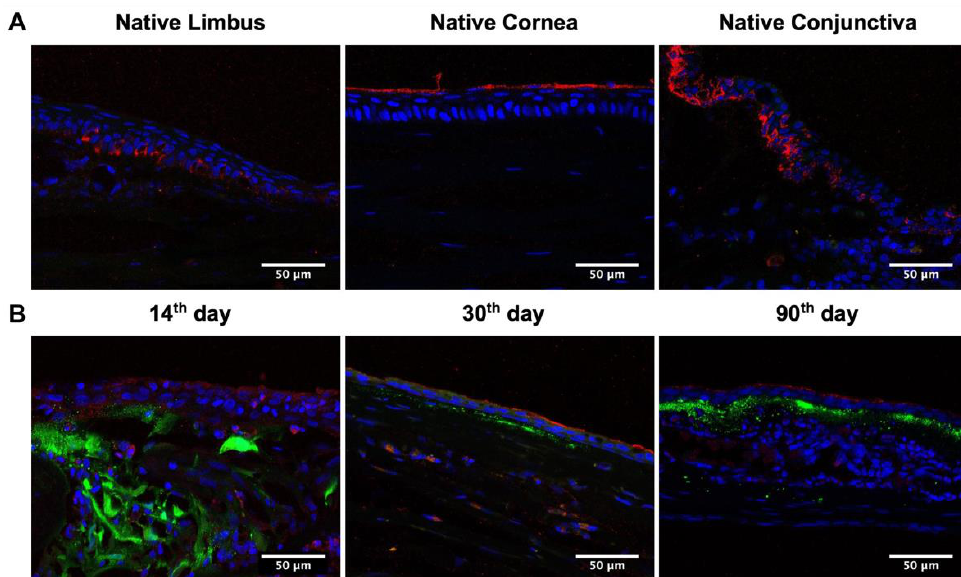
Figure 5. Immunohistochemical staining of rabbit corneas at different time points after transplanta- tion of L-MSCs-EGFP. Red—staining with antibodies against cytokeratin 15; green—GFP channel; blue—DAPI. ( A ) Native tissue in the area of the limbus, cornea, and conjunctiva. ( B ) Corneal tissue on the 14th, 30th, and 90th days after transplantation of L-MSCs-EGFP. Laser scanning confocal microscopy. Scale bars: 50 μm.